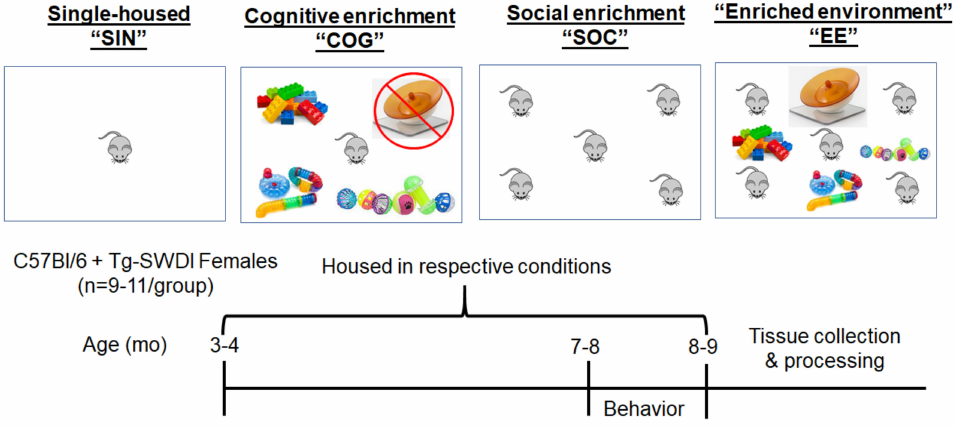
Figure 2. Overview of housing conditions and timeline of the experiment. At ~3–4 months of age, C57Bl / 6 and Tg-SwDI female mice were randomly assigned to one of four housing conditions: SIN (single housed), COG (single housed with cognitively stimulating toys switched out twice weekly), SOC (group housed), and EE (group housed mice with toys and running wheel). Following 4 months in the respective housing conditions, mice underwent a battery of behavior tests, and tissue was collected (end age = ~8–9 months). Within housing conditions, access to a running wheel is indicated by the presence of an orange exercise saucer. Cognitive enrichment is indicated by the presence of multi-colored blocks, balls, and